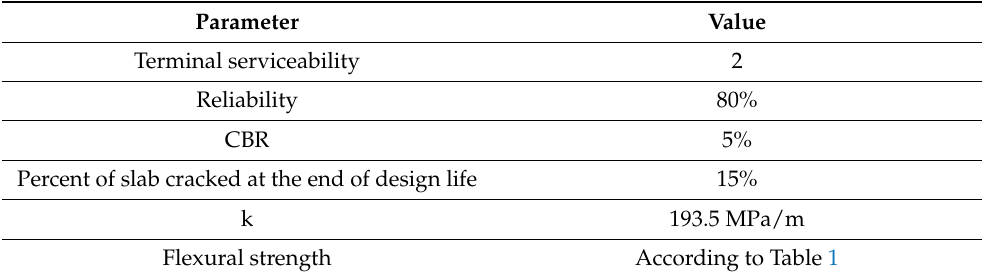
Table 5. Input parameters used in StreetPave design